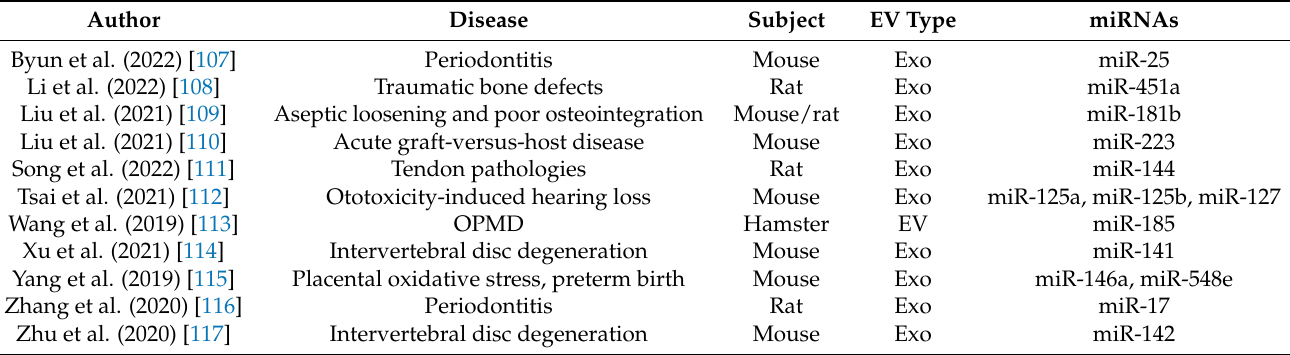
Table 8. Extracellular miRNAs in other inflammatory disease